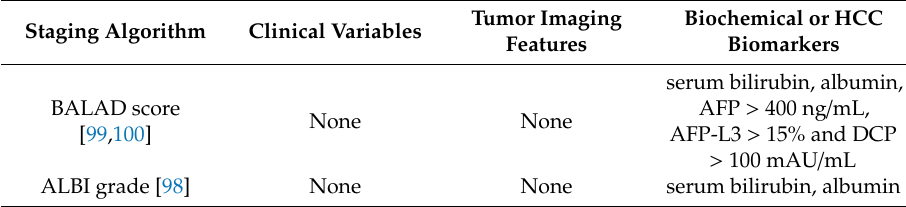
Table 3. Staging models for HCC prognosis including